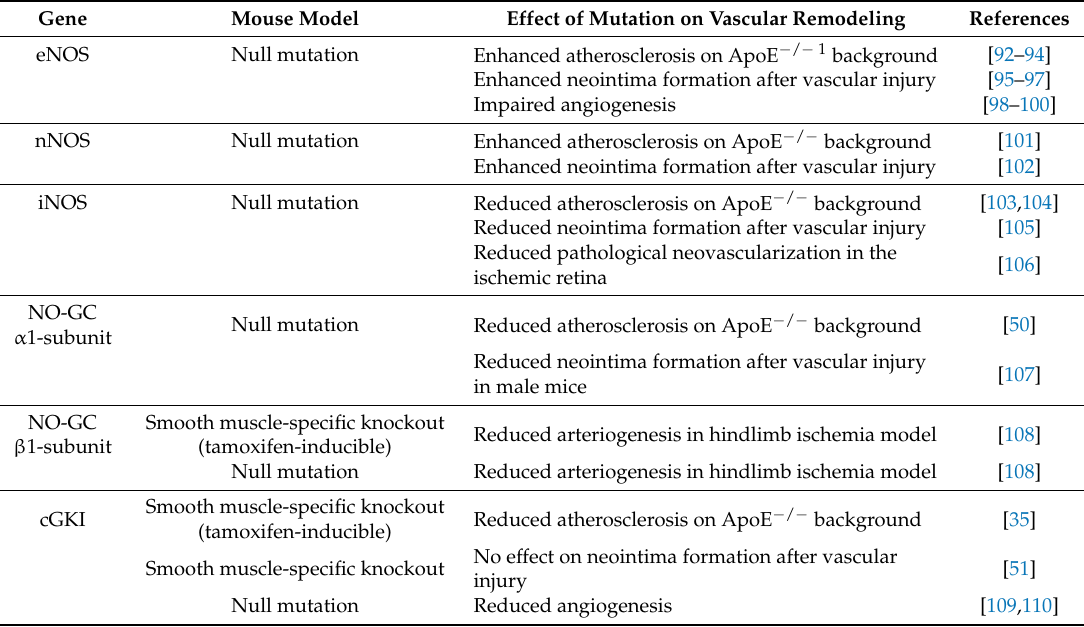
Table 1. Genetic mouse models of NO-cGMP-cGKI signaling and their vascular